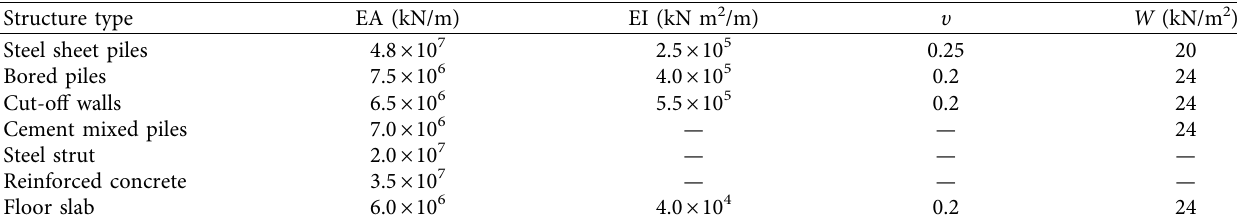
Table 3: Constitutive parameters of retaining